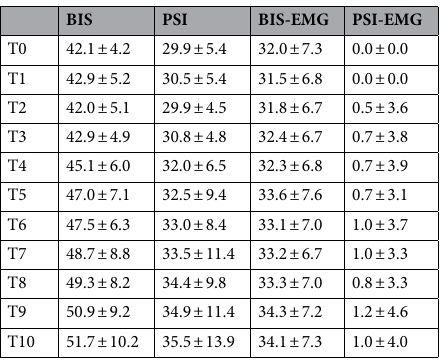
Table 2. Bispectral index (BIS) and patient state index (PSI) values during steady-state total intravenous anesthesia (TIVA). Data expressed as mean ± SD. BIS-EMG bispectral Index values with electromyography, PSI-EMG Patient State Index values with